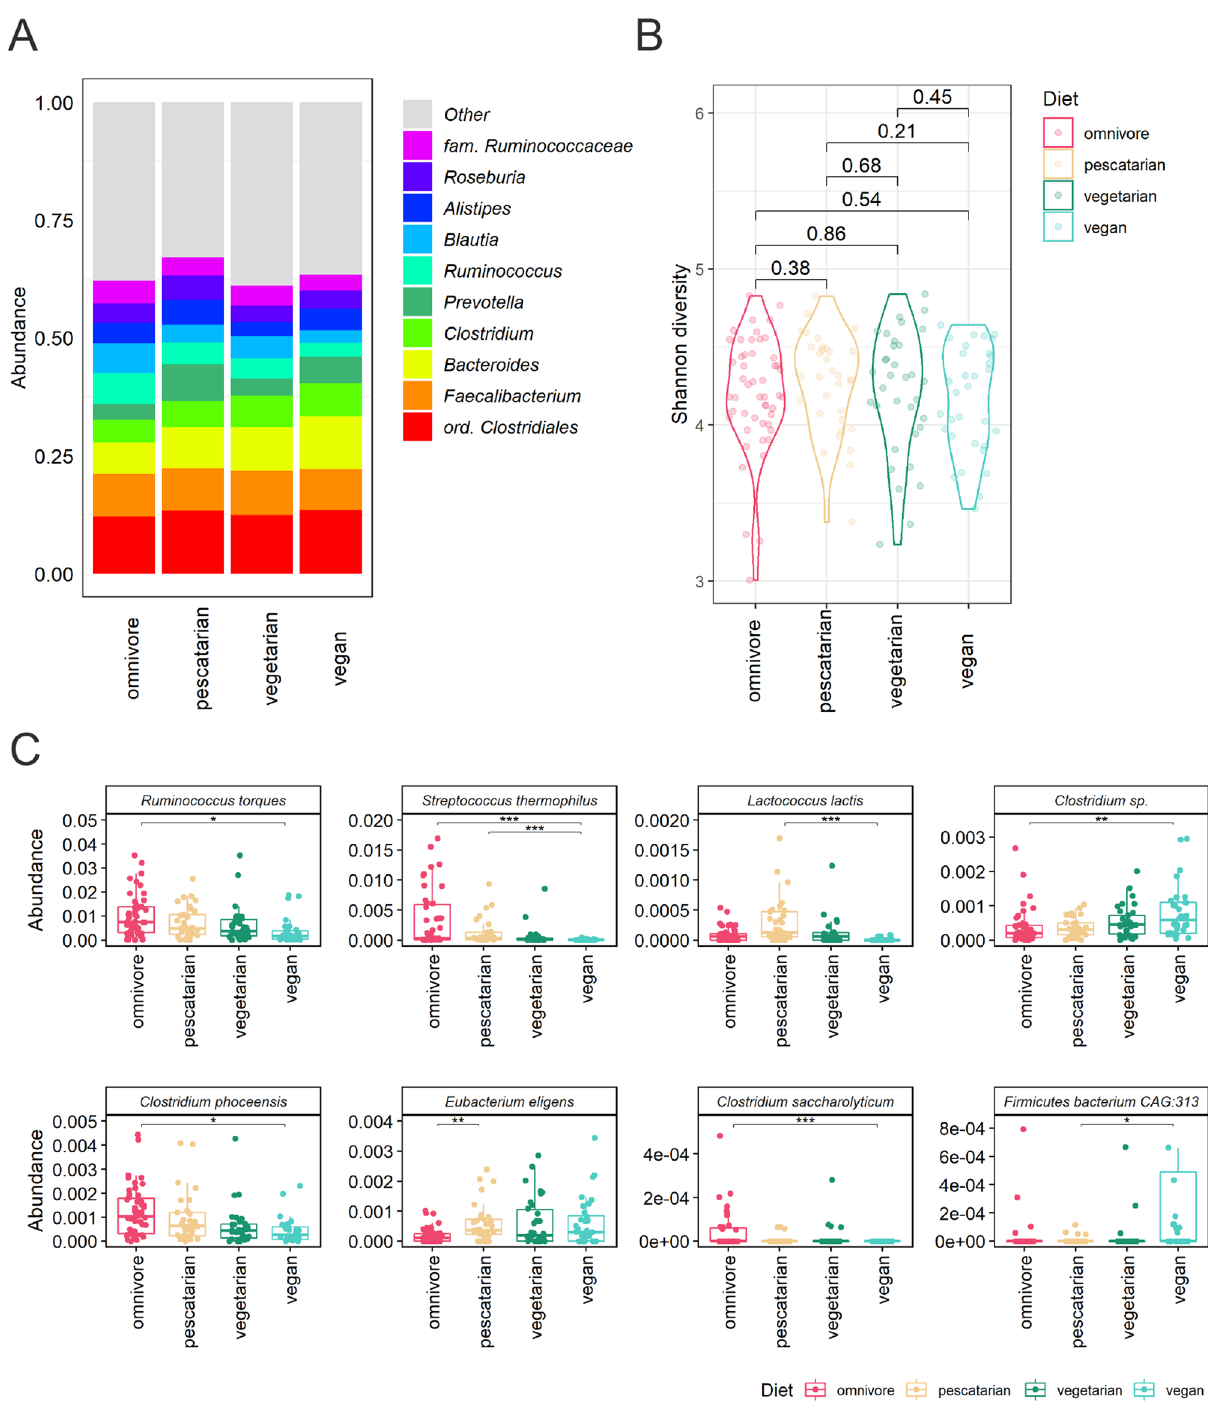
Figure 1. Association of dietary habits and the gut microbiome composition. ( A ) Relative abundance of the 10 most abundant bacterial genera per diet group. ( B ) Alpha diversity per diet group expressed by Shannon index. Differences in alpha diversity between diet groups were compared using Wilcoxon rank-sum tests. ( C ) ANCOM-BC analysis for differential relative abundance of bacterial species between diet groups. Abundance was plotted on the relative abundance scale from 0.00 to 1.00. Adjusted p values are indicated by *< 0.05, **< 0.01 and ***<